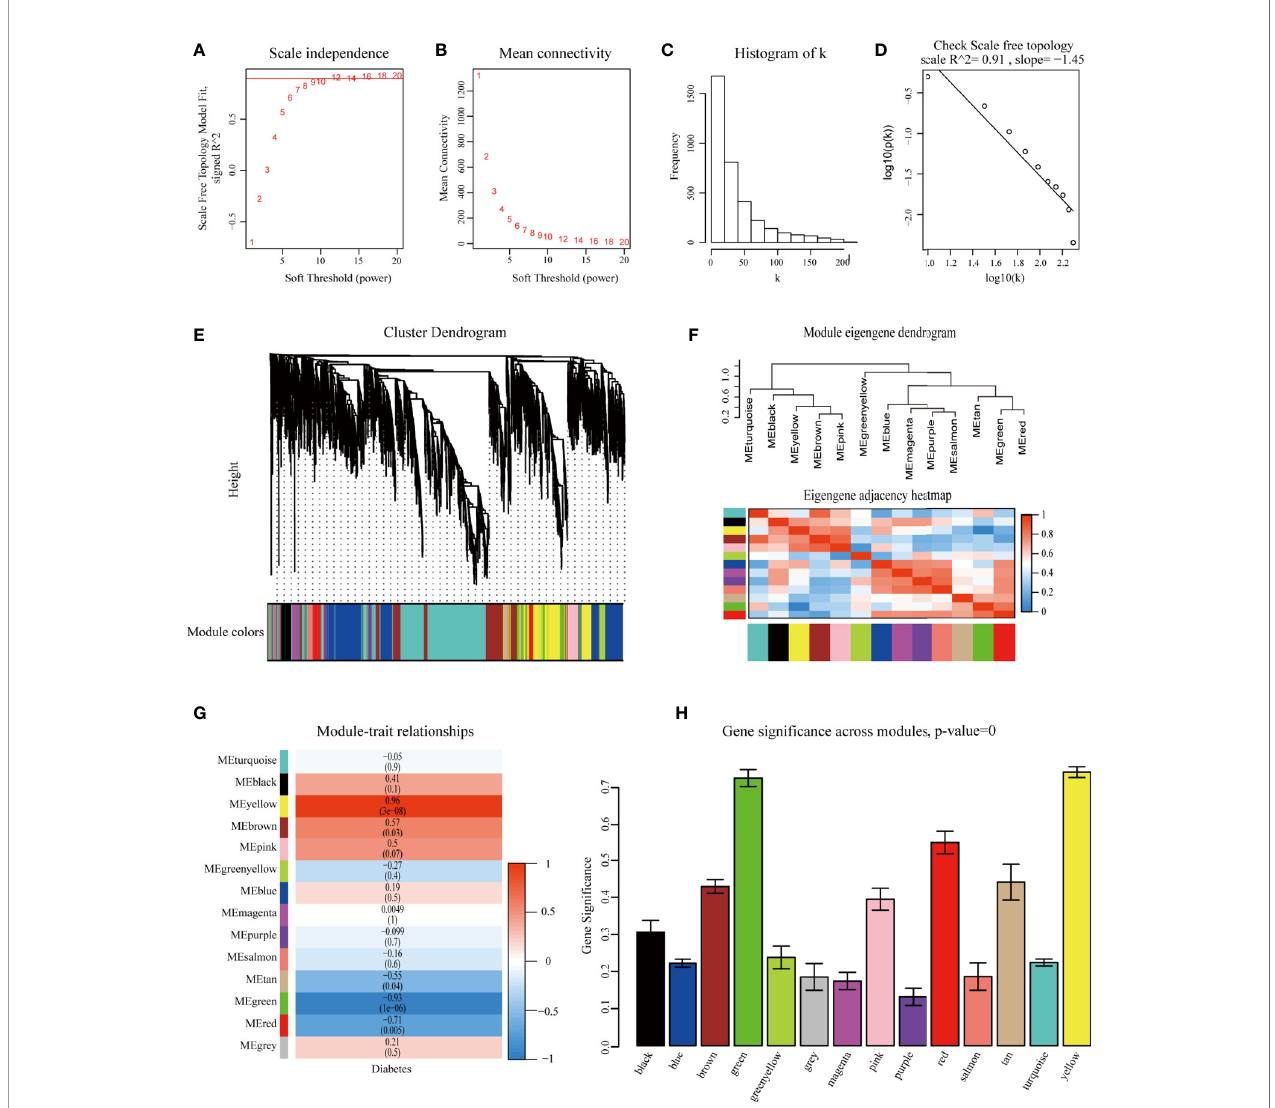
FIGURE 2 | Identi fi cation of modules associated with diabetic cardiomyopathy using the weighted gene co-expression network analysis (WGCNA). (A) Analysis of the scale-free fi t index for various soft-thresholding powers ( b ). (B) Analysis of the mean connectivity for various soft-thresholding powers. (C) Histogram of connectivity distribution when b =12. (D) Checking the scale-free topology when b =12. Identi fi cation of modules associated with diabetic cardiomyopathy. (E) Dendrogram of the top 25% most variant genes clustered based on a dissimilarity measure (1-TOM). (F) Module eigengene dendrogram and eigengene network heatmap summarize the modules yielded in the clustering analysis. (G) Heatmap of the correlation between module eigengenes and diabetic cardiomyopathy. (H) Distribution of average gene signi fi cance and errors in the modules associated with diabetic cardiomyopathy. TOM, Topological Overlap